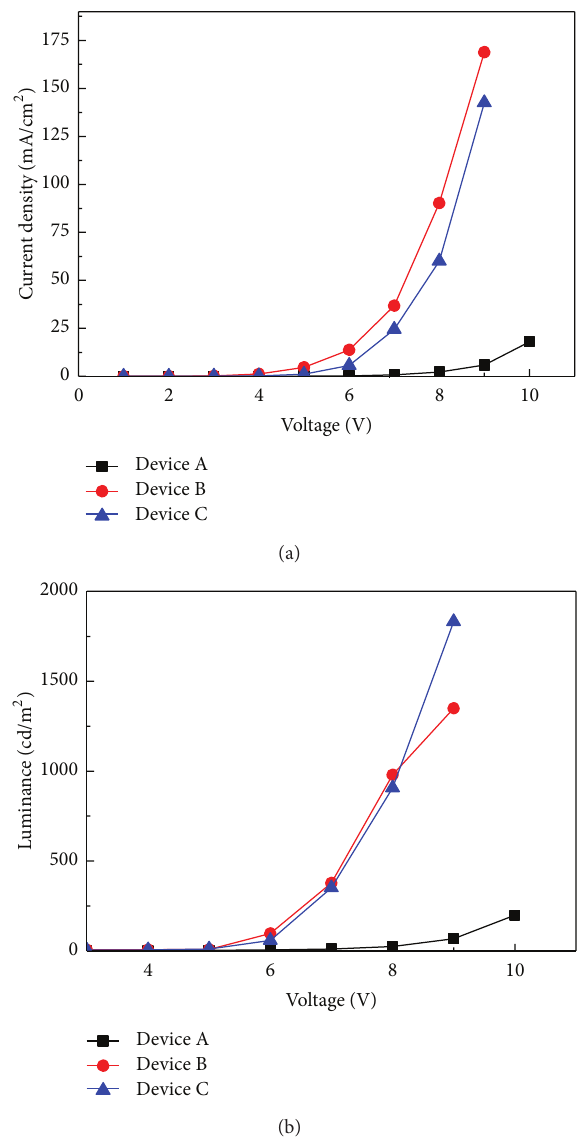
Figure 2: The (a) current density-voltage and (b) luminance-voltage characteristics of the devices